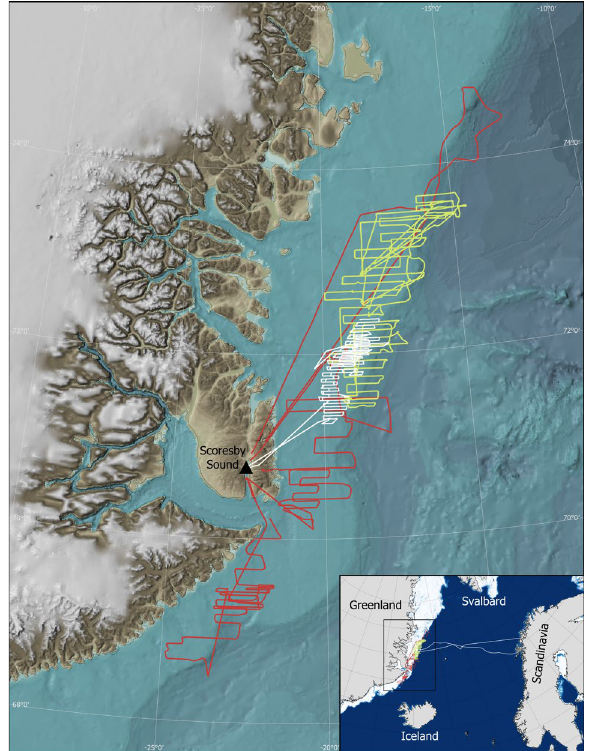
Figure 1. Reconnaissance surveys conducted by the fixed-wing aircraft (red) and helicopter (yellow) in the Greenland Sea during the period 18– 30 March 2018. Also shown are the final photo surveys (white). The white line in the inset map represents the ship's track between Norway and the Greenland